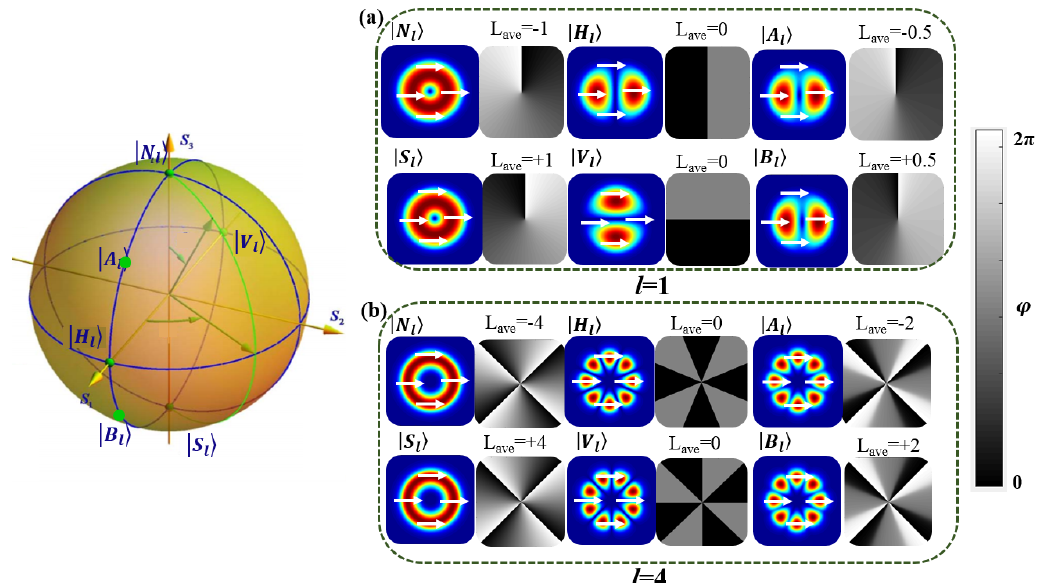
Figure 2. ( a ) Intensity profiles, polarization states and the phase distributions of superimposed mode when l = 1 and ( b ) l = 4. The north pole N l and south pole S l represent orthogonal circularly polarized modes with topological charges of − l and + l ; The points H l and V l represent the two points on the equator; The A l and B l points of ( a ) represent the two modes with average orbital angular momentum (OAM) values of − 0.5 and 0.5 for l = 1. The A l and B l points of ( b ) represent the two modes with average OAM values of − 2 and 2 for l = 4.